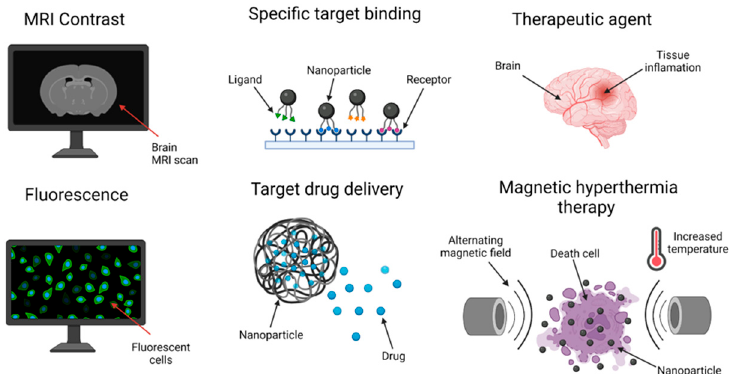
Figure 1. MNPs’ biomedical applications.